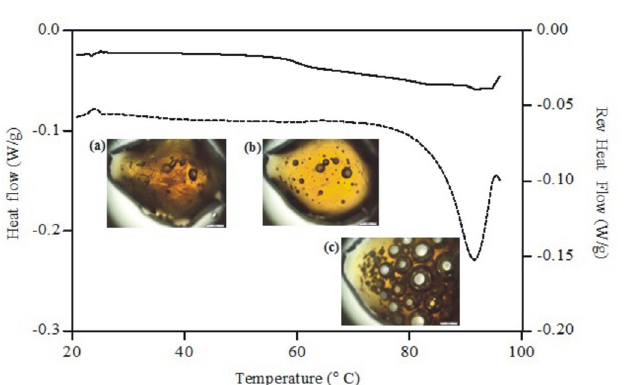
FIGURE 2 - Typical total (dots) and reversed (line) heat flow curves for guava extract. DSC thermogram of extract with photomicrographs of guava extract during a heating program for 2 °C/min between 20 °C and 100°C, at 20 ºC (a), at 60 ºC (b) and at 90 ºC (c) (Scale bar = 200